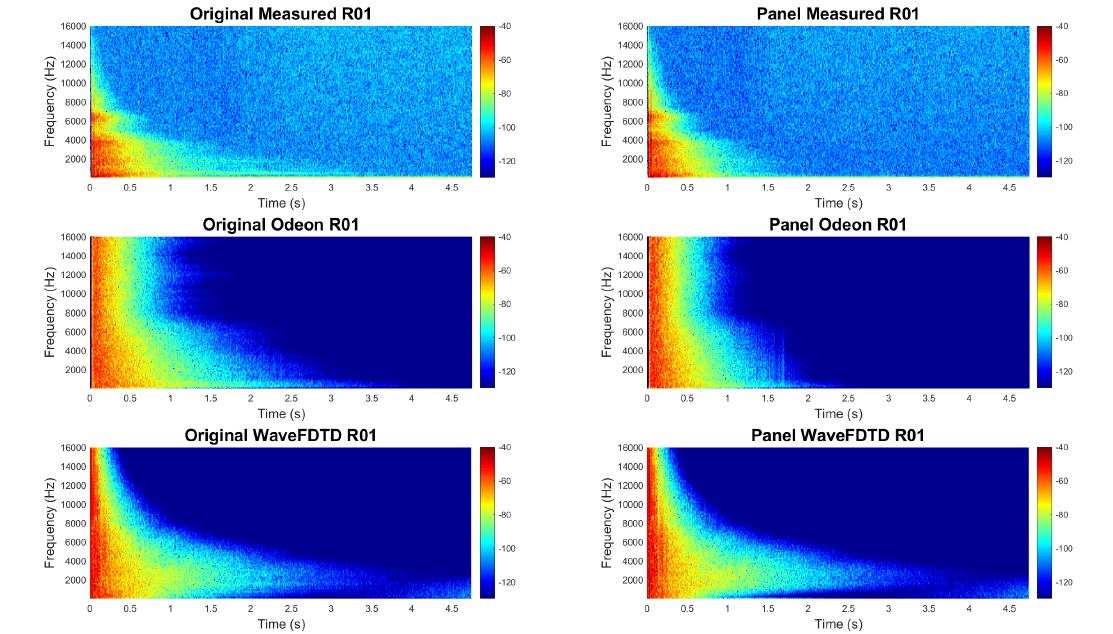
Figure 7. Spectrograms for receiver location R01 (in audience area, 3m from source); before and after the addition of the acoustical panels.